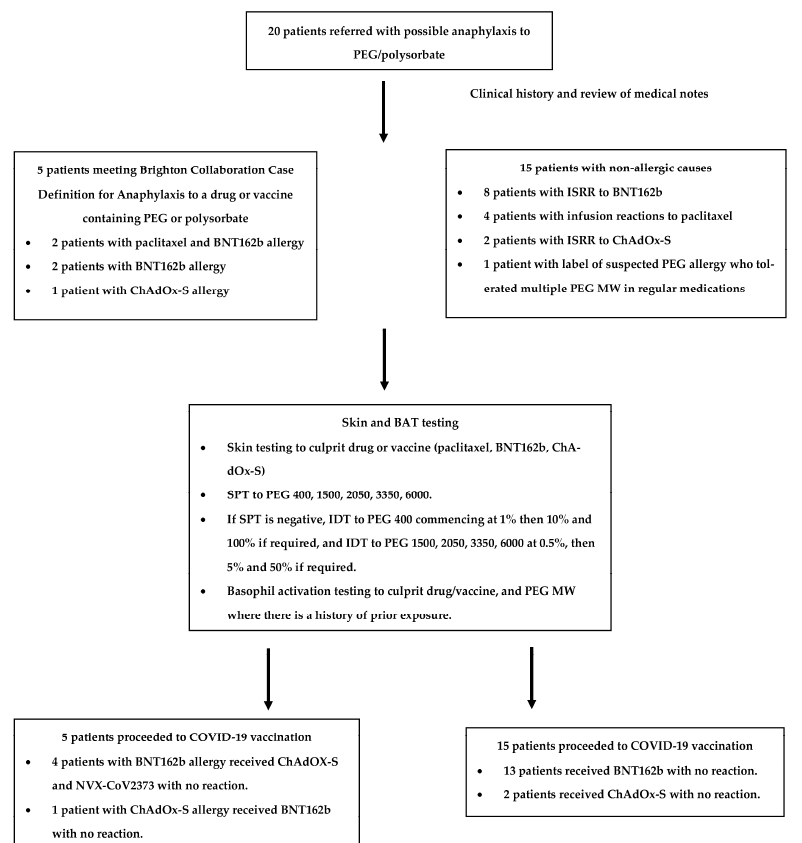
Figure 1. Process of assessment and results for enrolled patients. Table 2. Clinical Characteristics and Results of Intradermal Testing and Basophil Activation Testing in Allergic Patients.